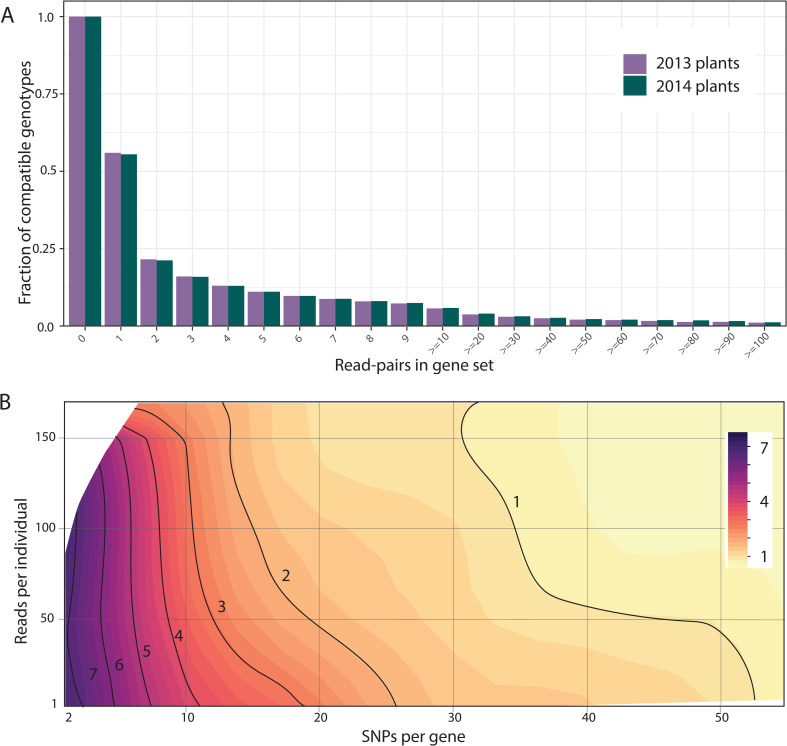
Testing haplotype matching: (A) In Mimulus, the precision of estimation is depicted as a function of the amount of data per plant. Compatible means that the likelihood for a genic-genotype is within 50% of the most likely genotype. (B) In Drosophila, the number of ancestors (indicated by contours and color) matching the genotype of a particular RIL is depicted as a function of amount of data (reads) and the number of SNPs in the gene set.